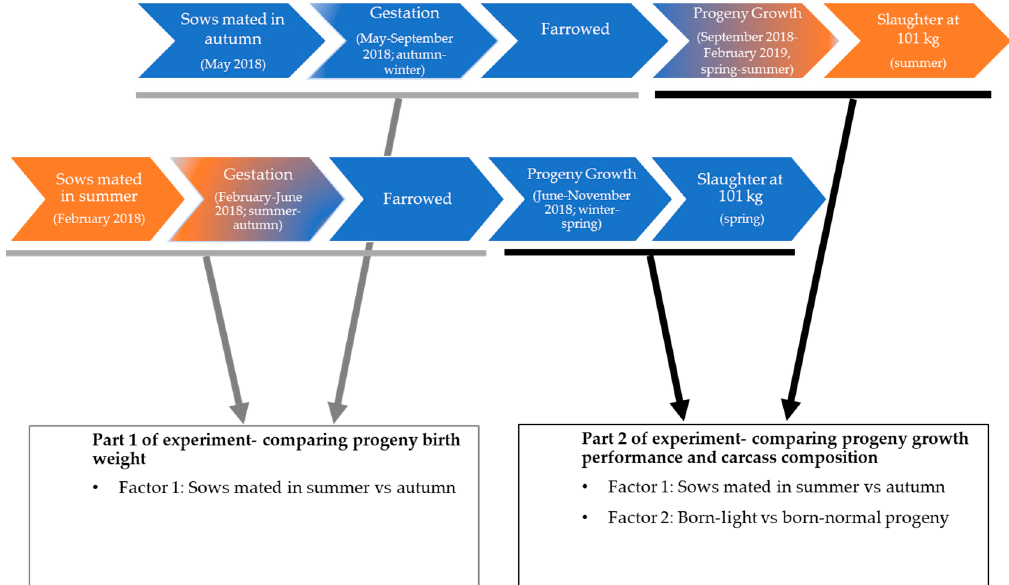
Figure 1. Flowchart of experimental design. In Part 1 of the experiment, physiological signs of thermal response during gestation and farrowing outcomes, including piglet birth weights, were compared between the sows mated in summer ( n = 119 sows; February 2018, Australia) vs. autumn ( n = 118 sows; May 2018, Australia). In Part 2 of the experiment, progeny of pigs that were born to the sows mated in summer and autumn were stratified as born-light (0.7–1.1 kg range) and born-normal (1.3–1.7 kg range) and grown to 101 kg live weight. Growth performance (from 9 weeks of age to 101 kg live weight) and carcass composition of progeny pigs were compared using two-way ANOVA for the effects of the mating season of sows (summer vs. autumn), progeny birth weight category (born-light vs. born-normal) and their interaction.